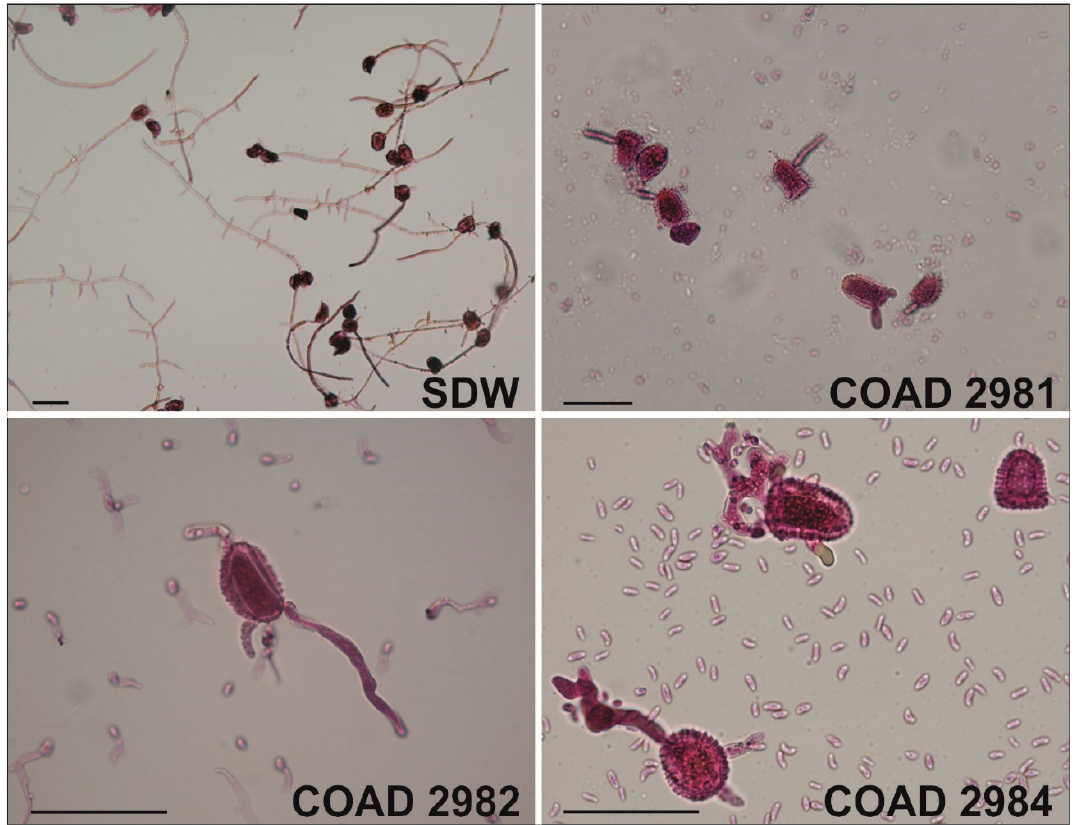
Figure 8. Clonostachys rhizophaga and C. rosea vs. Hemileia vastatrix: effects of suspensions of conidia on germination of urediniospores of H. vastatrix . SDW (control): normal germination of urediniospores suspended in sterile distilled water; COAD 2981: inhibition of germination and stubby distortion of urediniospore germ tubes exposed to presence of C. rhizophaga (isolate COAD 2981); COAD 2982: ibid. exposure to isolate COAD 2982 of C. rhizophaga ; COAD 2984: ibid. exposure to isolate COAD 2984 of C. rosea . Bars = 50 µm.